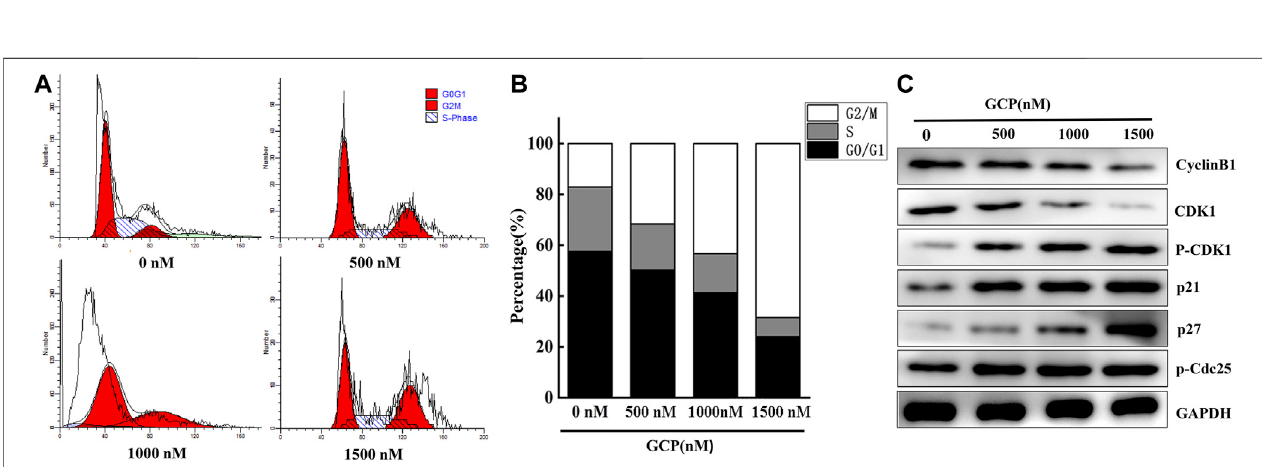
FIGURE3| GCPinhibits theexpression ofCDK1 and PLK1. HeLacells weretreated with 1,500 nM for 24 – 72 h, (A) western bolt analysisthe expression ofCDK1 and PLK1. GAPDH was used as internal control. (B) Biological activity of PLK1 PBD protein was measured by Fluorescence polarization assays. (C) CDK1 activity was examined after incubation with different GCP doses and for different lengths of time using a kit. (D, E) The relative expression of PLK1 and CDK1 was evaluated by RT- qPCR analysis.